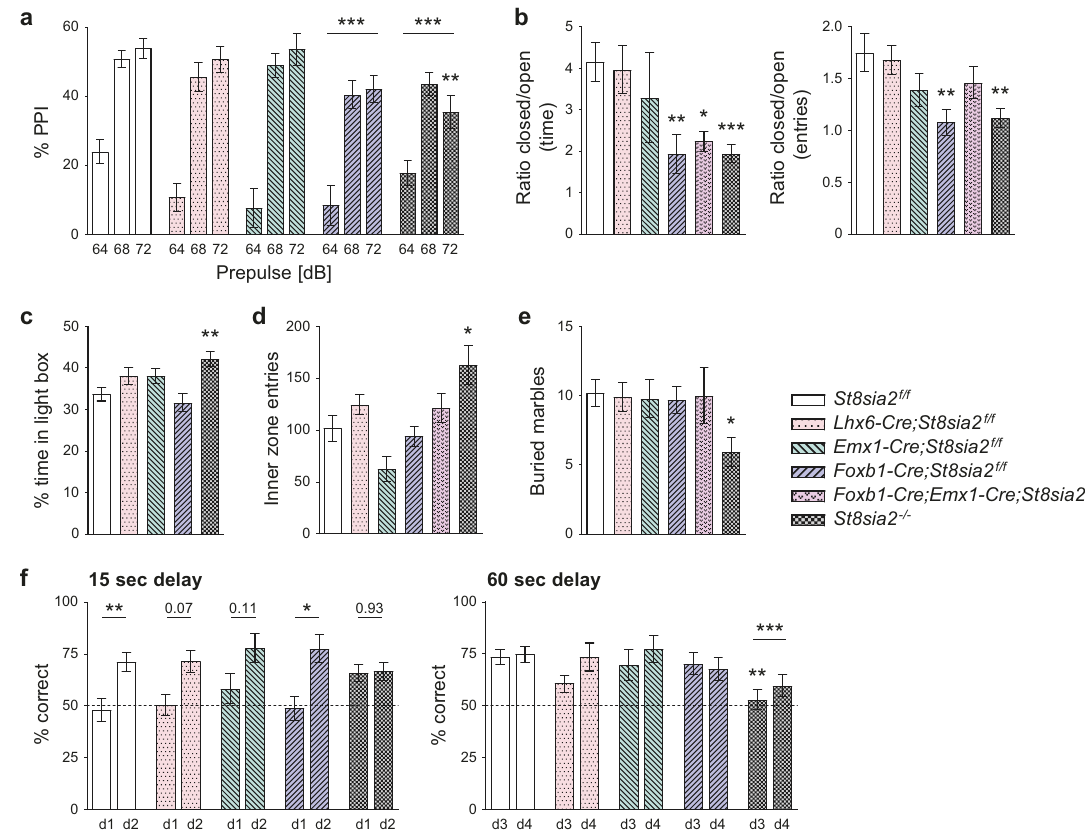
Fig. 5 Ablation of St8sia2 by Foxb1 - Cre impairs PPI and reduces anxiety in the elevated plus maze, but has no effect in other tests of anxiety-like behavior or on working memory. a PPI of the acoustic startle response after prepulses of 64, 68, and 72 dB in mice treated with 5 mg/kg apomorphine. Graphs show means ± SEM of n = 37, 18, 17, 18, and 27 St8sia2 f/f , Lhx6-Cre;St8sia2 f/f , Emx1-Cre;St8sia2 f/f , Foxb1-Cre; St8sia2 f/f , and St8sia2 − / − mice, respectively. b Elevated plus maze. Ratios between the time spent in the closed versus the open arm of the elevated plus maze (left), and between the numbers of closed and open arm entries (right). Graphs show means ± SEM of n = 15, 23, 6, 17, 5, and 21 (left) or n = 16, 24, 6, 19, 6, and 22 (right) St8sia2 f/f , Lhx6-Cre;St8sia2 f/f , Emx1-Cre;St8sia2 f/f , Foxb1-Cre;St8sia2 f/f , Foxb1-Cre;Emx1-Cre;St8sia2 f/f , and St8sia2 − / − mice, respectively. c – e Percent of time spent in the light compartment of a dark-light box ( c ), number of entries into the inner zone of the open fi eld ( d , experienced mice, see Fig. 4c) and number of marbles buried in the marble burying test ( e ). Graphs show means ± SEM of n = 16, 20, 17, 15, and 18 St8sia2 f/f , Lhx6-Cre;St8sia2 f/f , Emx1-Cre;St8sia2 f/f , Foxb1-Cre;St8sia2 f/f , and St8sia2 − / − mice ( c ), or n = 12, 10, 5, 16, 14, and 17 ( d ) and n = 23, 24, 18, 23, 9, and 20 ( e ) St8sia2 f/f , Lhx6-Cre;St8sia2 f/f , Emx1-Cre;St8sia2 f/f , Foxb1-Cre;St8sia2 f/f , Foxb1-Cre;Emx1-Cre; St8sia2 f/f , and St8sia2 − / − mice, respectively. f Delayed nonmatch-to-place T-maze task. Percent correct choices (arm alterations) of mice tested on day 1 and 2 (d1, d2) with a forced delay of 15 s (left) and on day 3 and 4 (d3, d4) with a forced delay of 60 s (right). Graphs show means ± SEM of n = 32 or n = 37 St8sia2 f/f controls for the tests with 15 or 60 s delay, and n = 17, 14, 16, and 25 Lhx6-Cre;St8sia2 f/f , Emx1-Cre;St8sia2 f/f , Foxb1-Cre;St8sia2 f/f , and St8sia2 − / − mice, respectively. Statistics: In a , two-way ANOVA indicated no signi fi cant interaction ( p = 0.059, F 1.90), but differences with p < 0.0001 for prepulse (F 2,336 = 105.0) and p = 0.0003 for genotype (F 4,336 = 5.53). In b , genotype comparisons for “ time ” were performed by Welch ’ s ANOVA after square root transformation, to meet the assumption of normal distribution (left), or by one- way ANOVA (right), indicating differences with p = 0.003 (W 5.0,25.13 = 5.01) or p = 0.001 (F 5,87 = 4.38). In c , d , and e , one-way ANOVA indicated differences with p = 0.003 (F 4,81 = 4.58), p = 0.001 (F 5,68 = 4.60), and p = 0.086 (F 5,111 = 1.99). In f , two-way RM ANOVA indicated for the 15 s delay test no signi fi cant interaction ( p = 0.14, F 4,99 = 1.77), no difference for genotype ( p = 0.41, F 4,99 = 1.01), but differences with p <